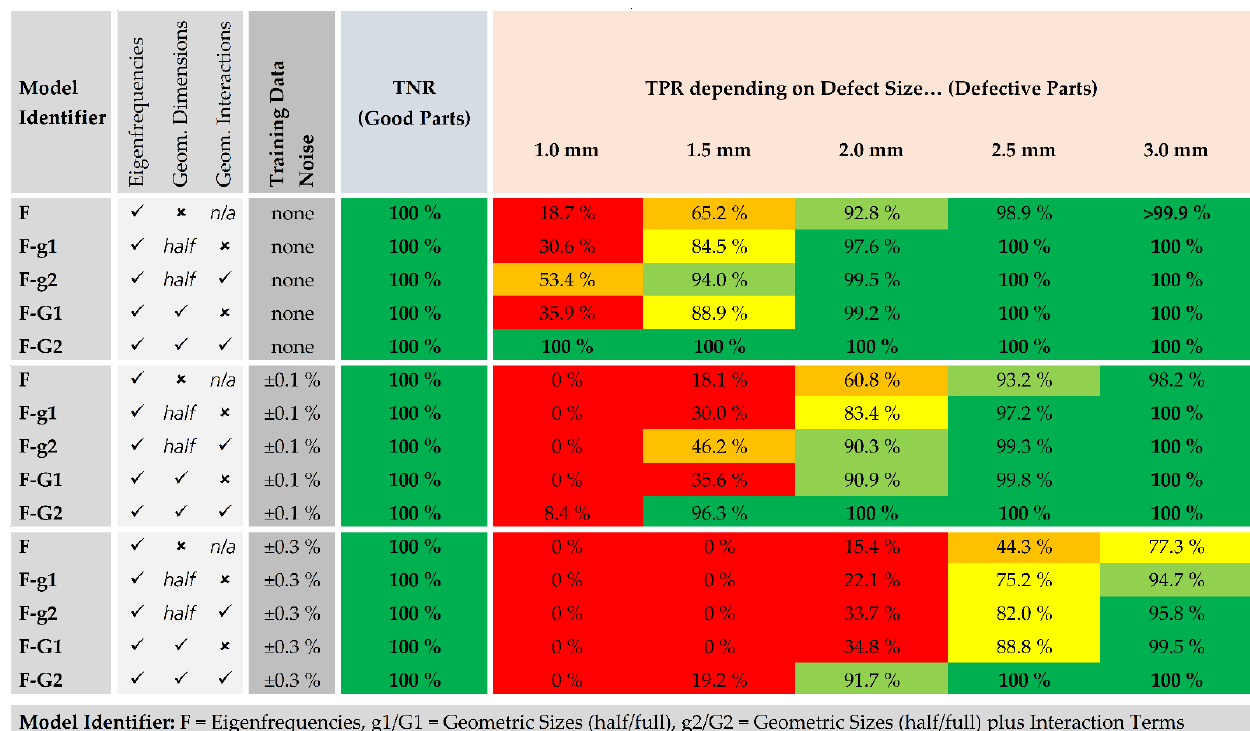
Figure 12. Overview of the classification results for virtual connecting rods being either undamaged or featuring a defect anywhere in the part with a size between 1 mm and 3 mm, based on various classification models derived from training datasets with different noise levels.